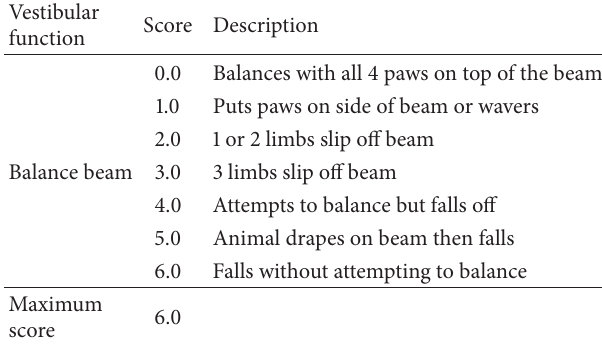
Table 2: Clinicl scoring